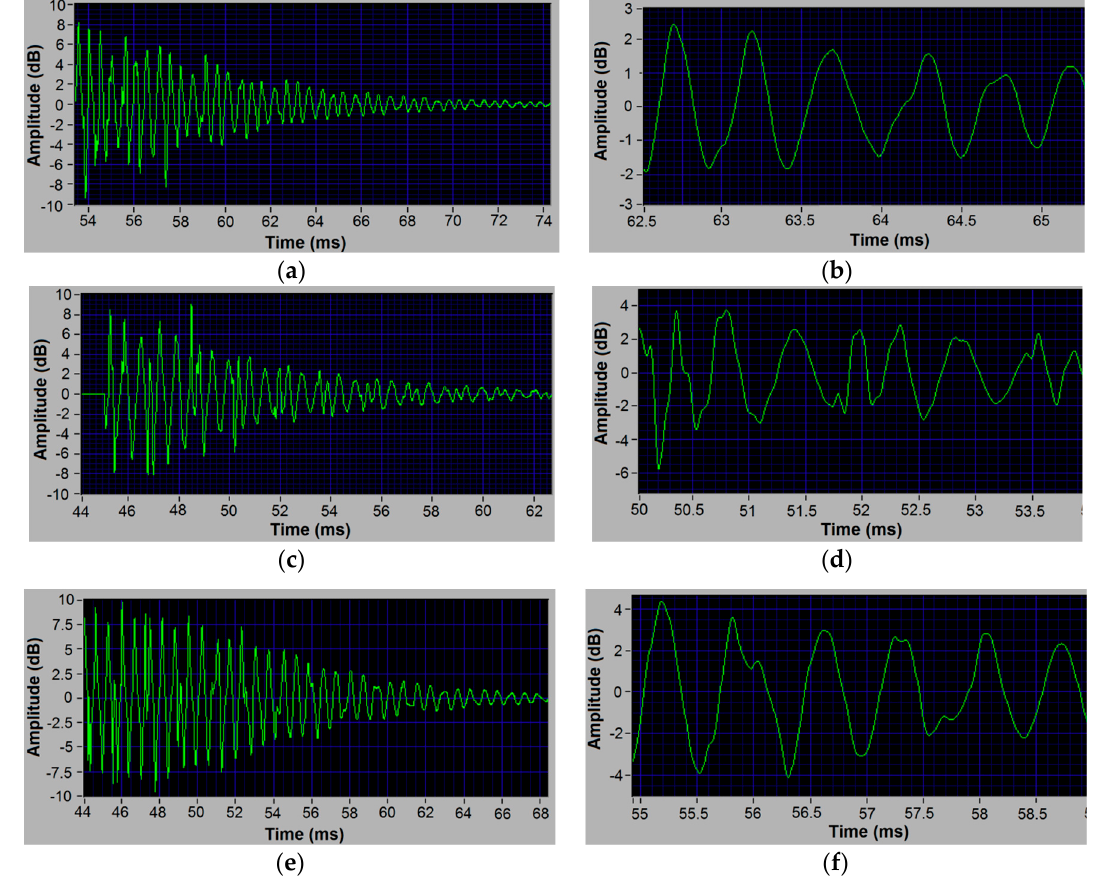
Figure 4. The original time-domain signal of specimen vibration. ( a ) The signal at 25 °C and ( b ) the corresponding enlarged image; ( c ) the signal at 75 °C and ( d ) the corresponding enlarged image; ( e ) the signal at 82 °C and ( f ) the corresponding enlarged image.